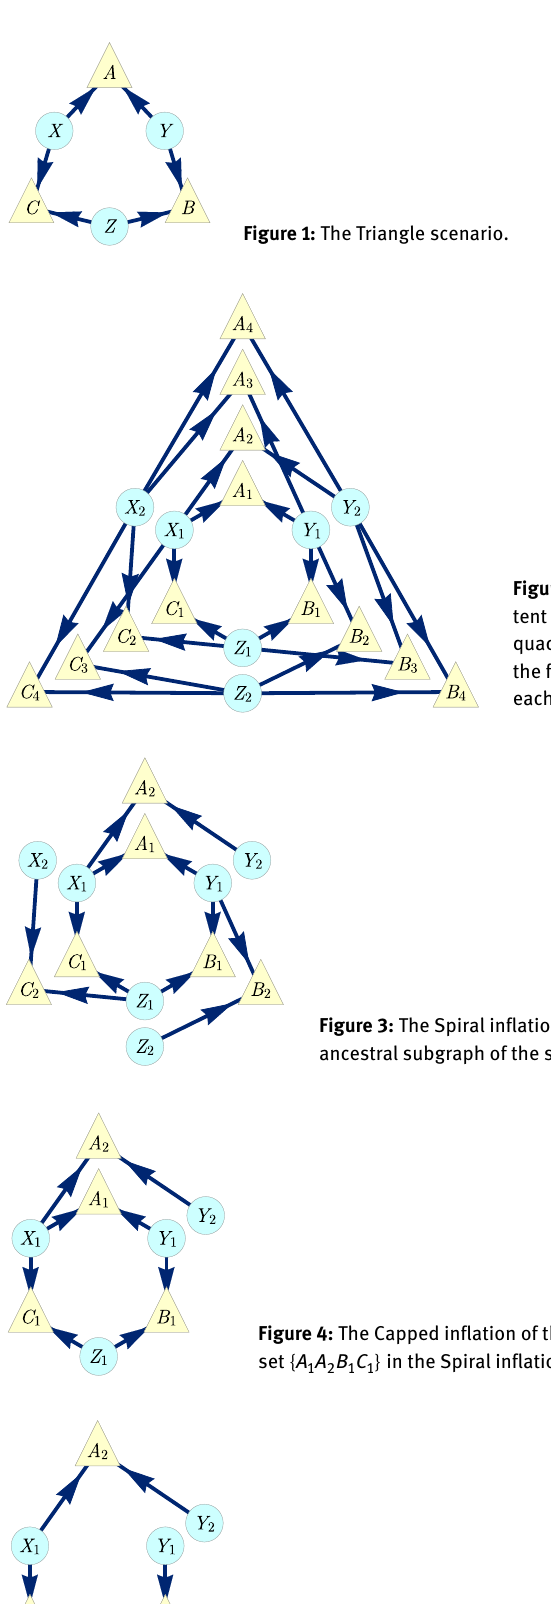
Figure 1: The Triangle scenario.